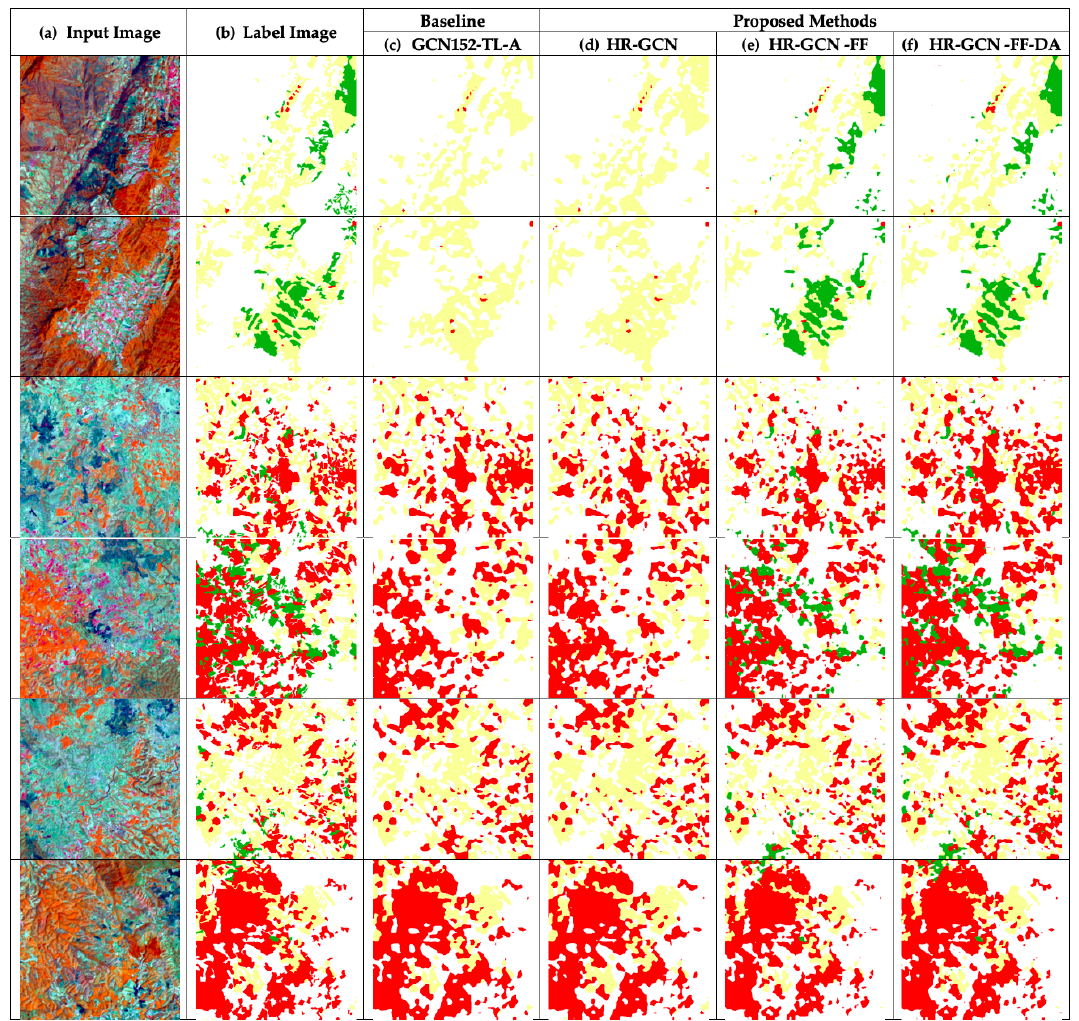
Figure 11. Comparisons between “HR-GCN-FF-DA” and beyond baseline methods of the Landsat-8w3c corpus testing